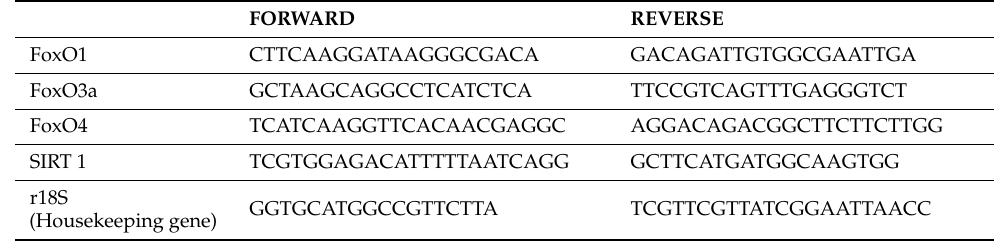
Table 2. RT-PCR primer